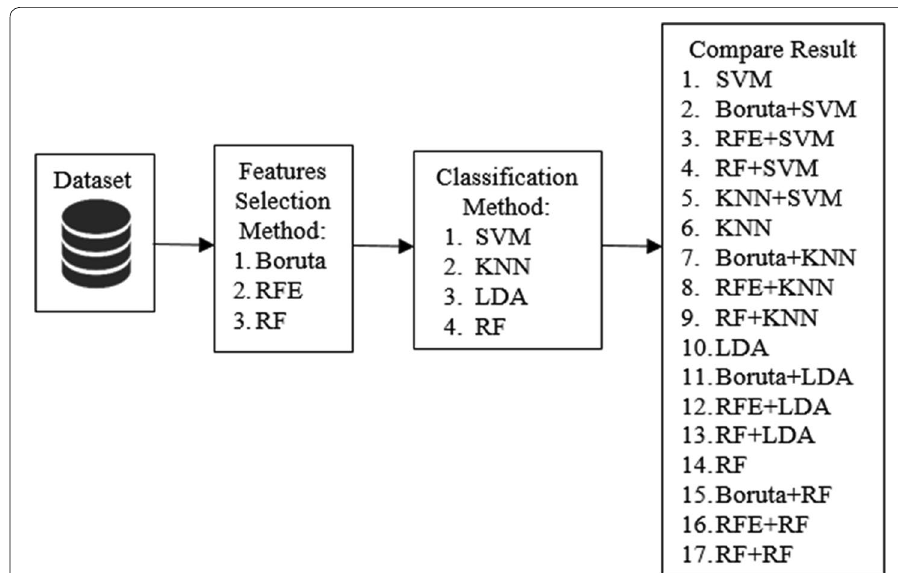
Fig. 1 The workflow of this research